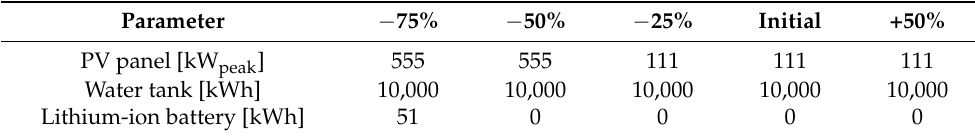
Table 8. Results of the component life cycle emission feasibility analysis.